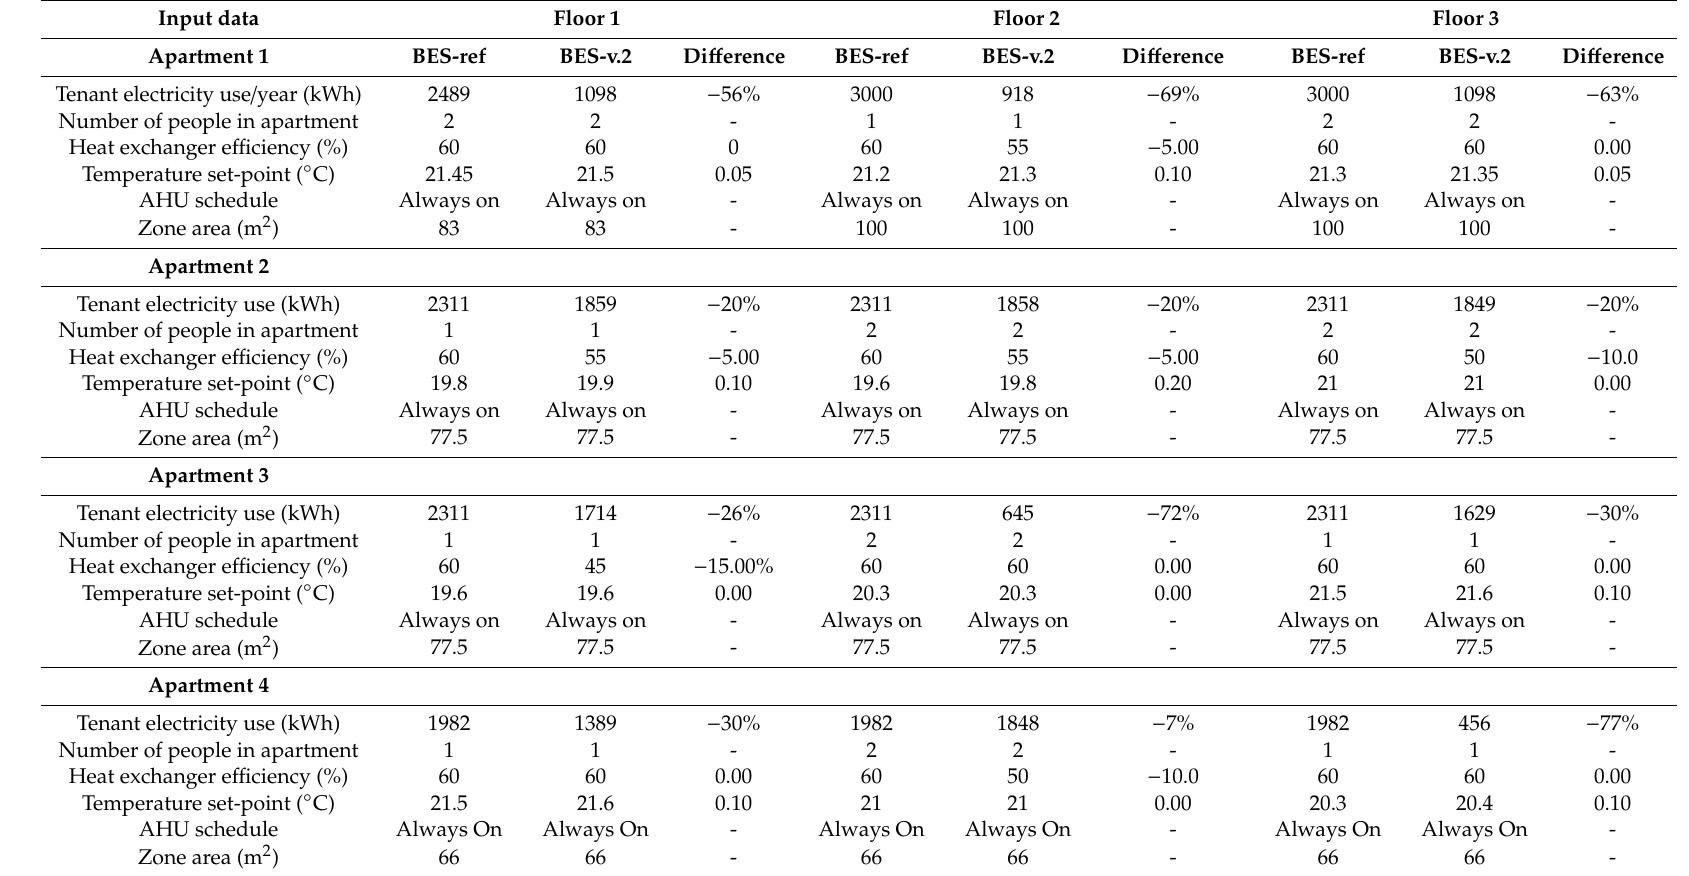
Table 7. Input data for BES-ref and